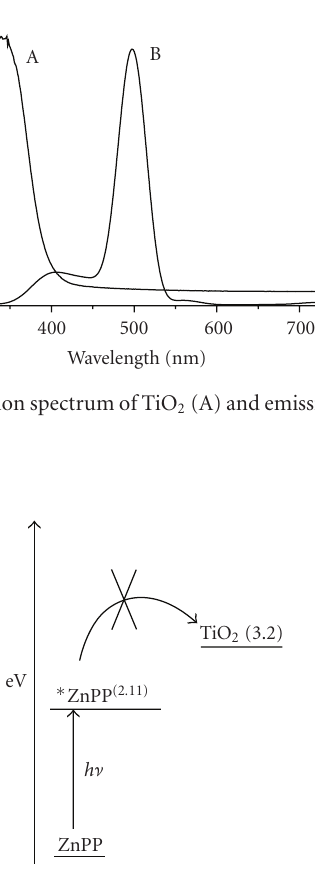
Scheme 2: Energy level diagram for ZnPP and TiO 2